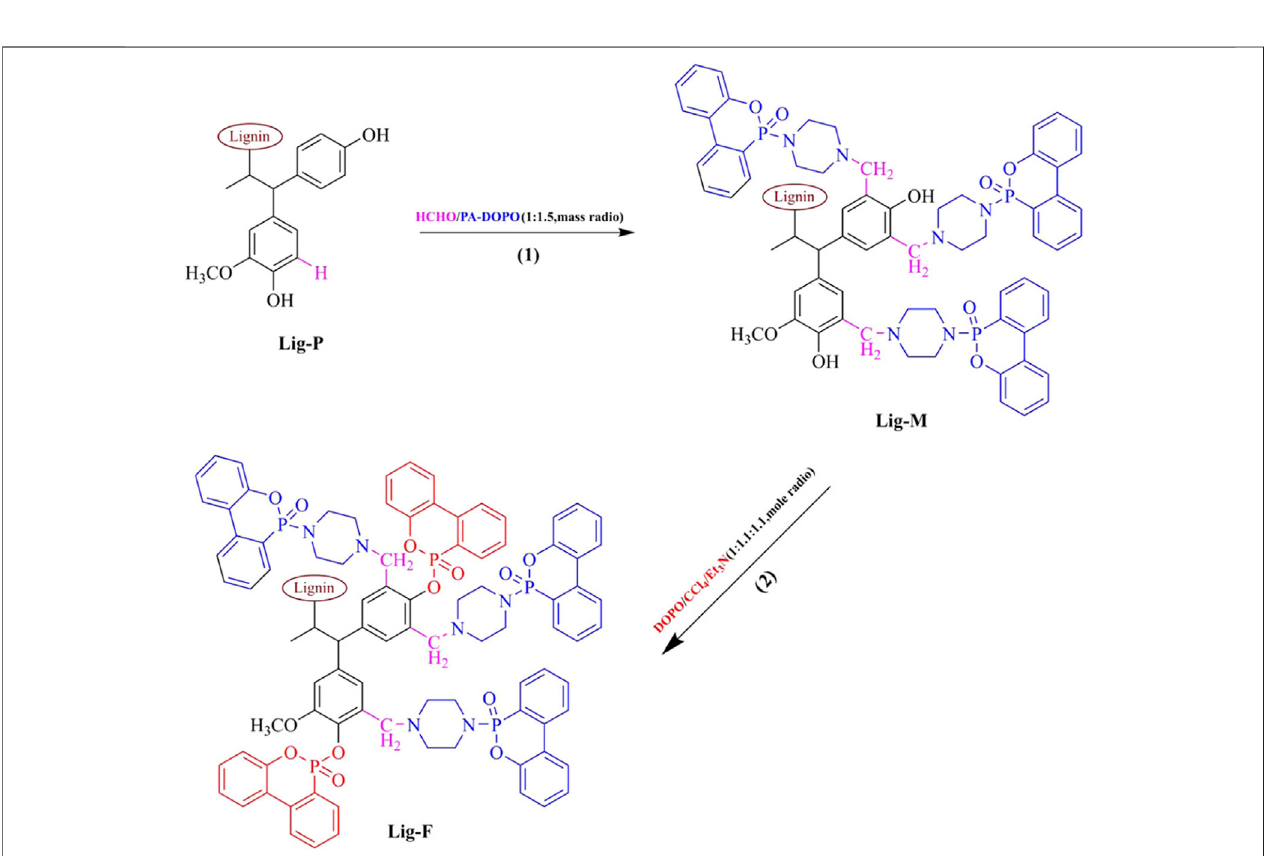
FIGURE 9 | Synthesis of P/N-containing lignin (Lig-M and Lig-F) (Dai et al., 2020).